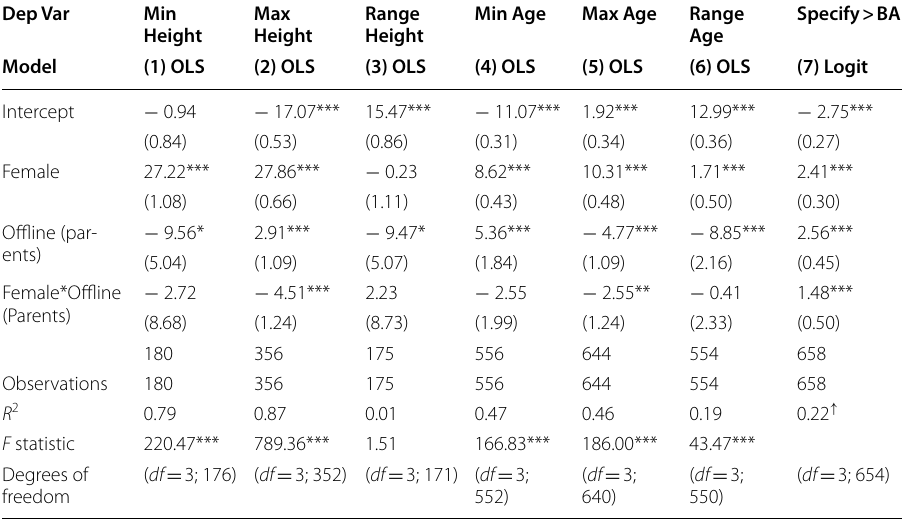
Table 4 Main effects and interaction effects of gender and parental preferences across age, height, and education. Beta coefficients are shown with corresponding p